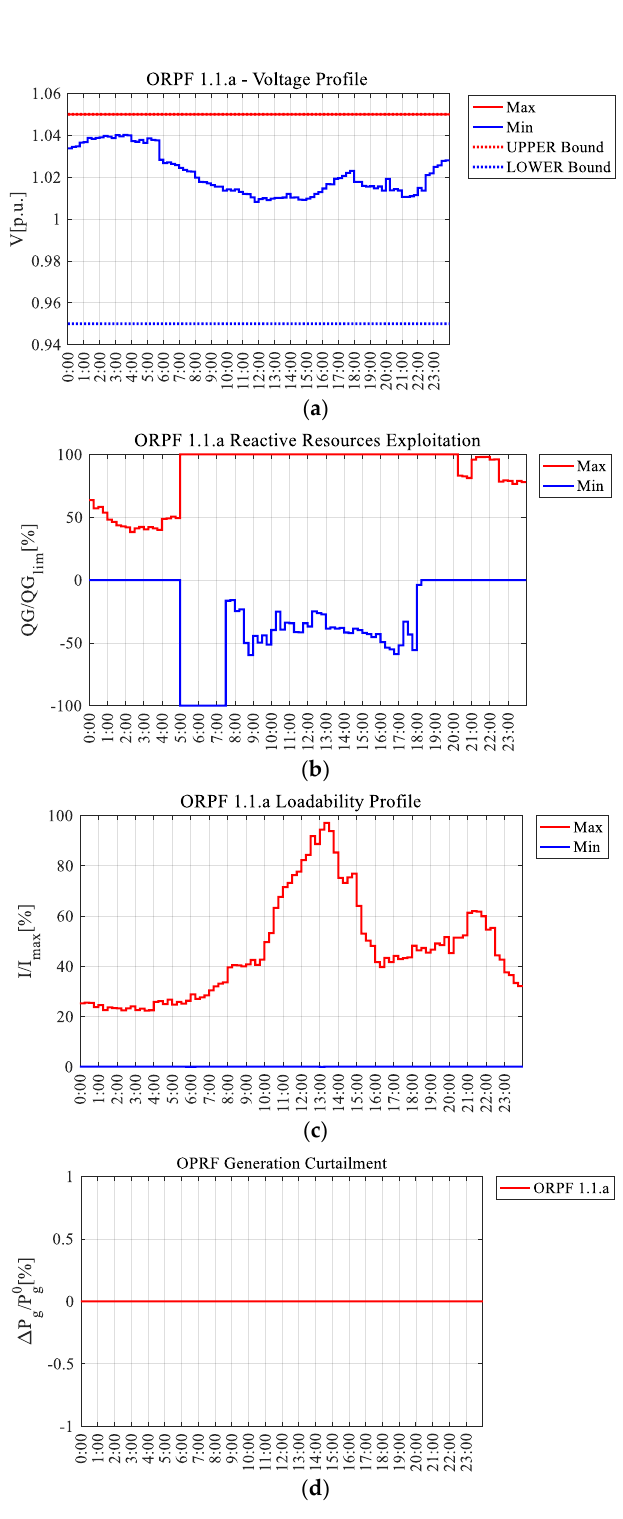
Figure 18 . ORPF 1.1.a results: ( a ) voltage profile; ( b ) reactive power response with respect to available capability; ( c ) DN’s loadability profile; ( d ) DG’s real power curtailment.